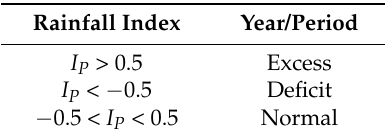
Table 2. Patterns of rainfall from the